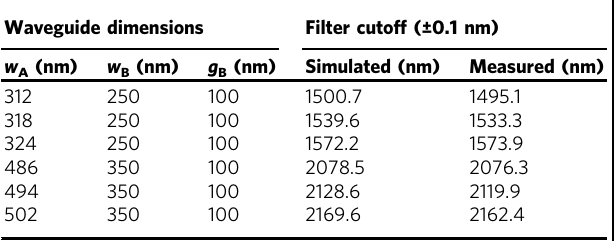
Table 1 Summary of simulated and measured cutoff wavelengths for the fabricated dichroic fi lters Waveguide dimensions